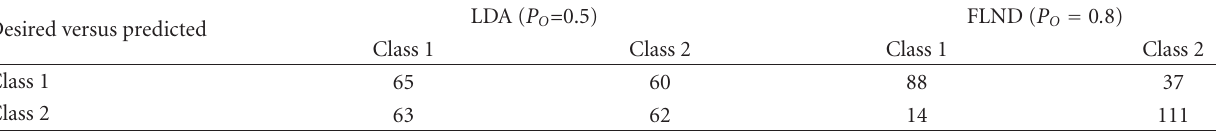
Table 1: Confusion matrices for LDA and FLND using X V .